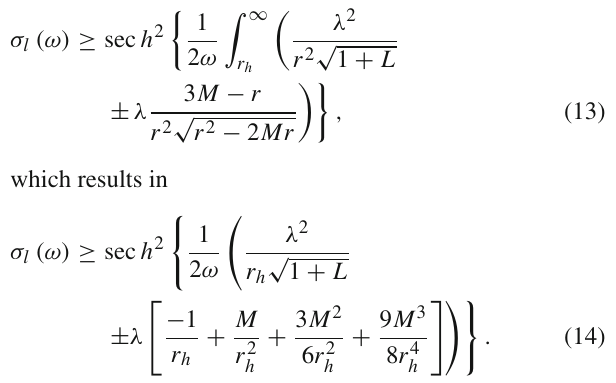
Fig. 3 Plot of σ l (ω) versus ω for spin-0 particles. The physical param- eters are chosen as follows: M = m = r = 1 , a = 0 . 1, and λ = 0